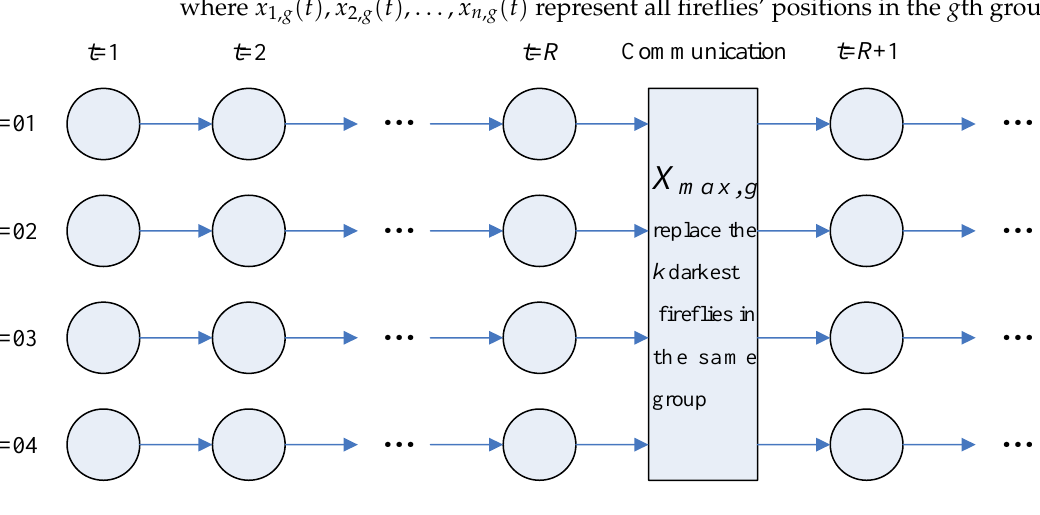
Figure 1. Strategy Figure 1. Strategy 1.